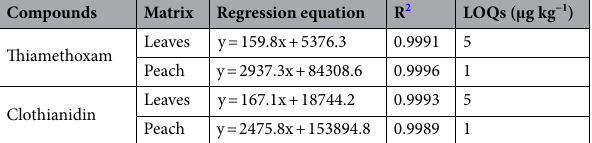
Table 2. Calibration equations, R 2 and